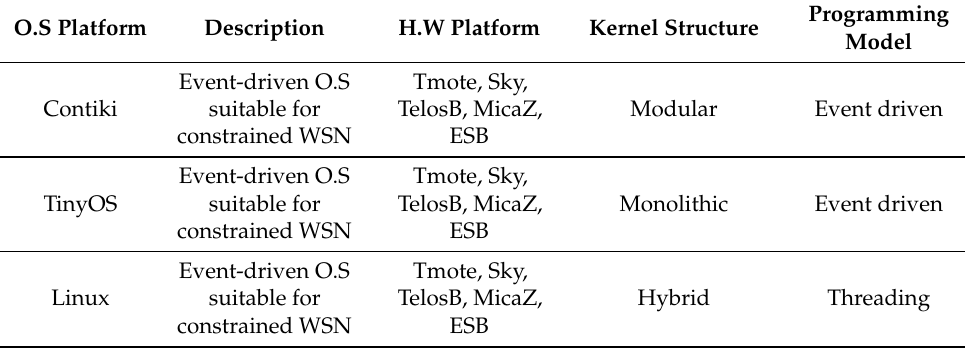
Table 2. Sensors Platforms for IoT in precision